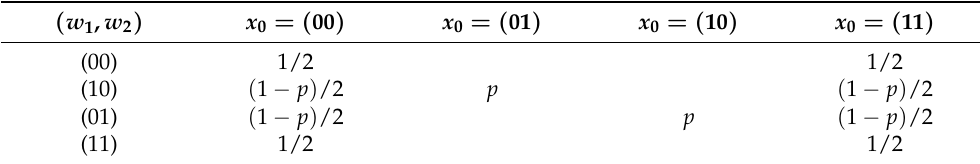
used in Corollary 0 | W 1 , W 2